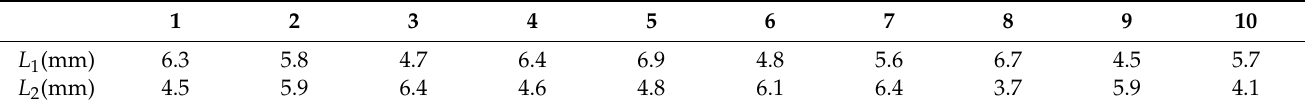
Table 1. The Psd area of the